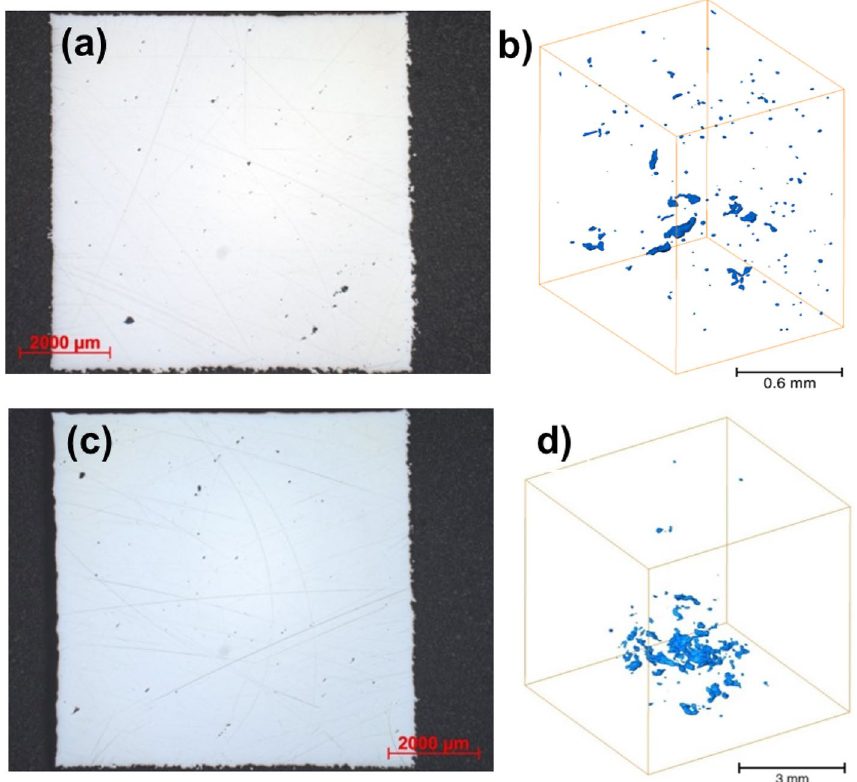
Figure 5. Porosity appearance of the CoCr alloy printed from virgin powder: on a 2D surface ( a ), and a cut section of the 3D microCT image ( b ), and on CoCr alloy printed from reused powder: on a 2D surface ( c ) and a 3D microCT image ( d